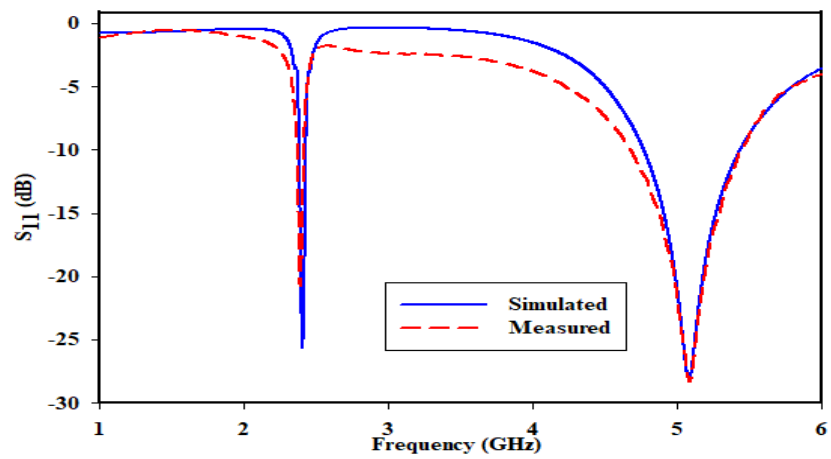
Figure 13. Simulated and measured return loss characteristics of the proposed ESA.